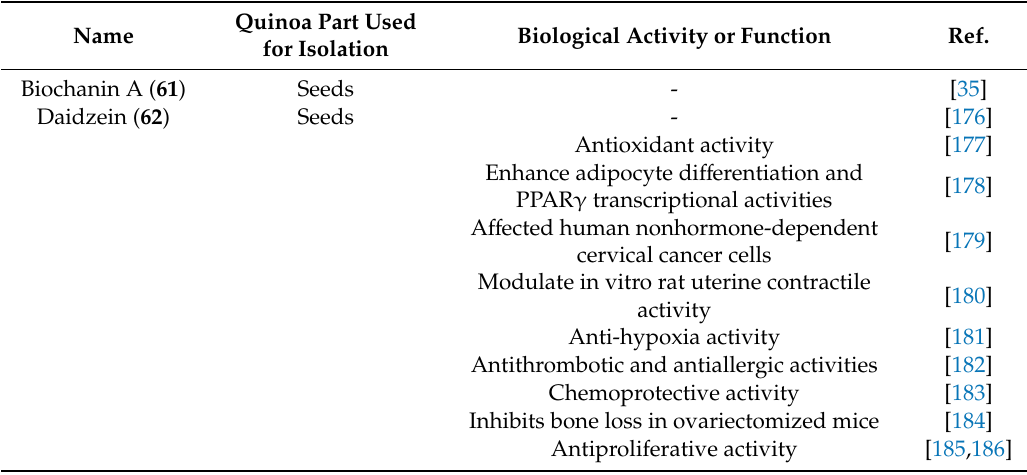
Table 7. Isoflavones and their biological activities or